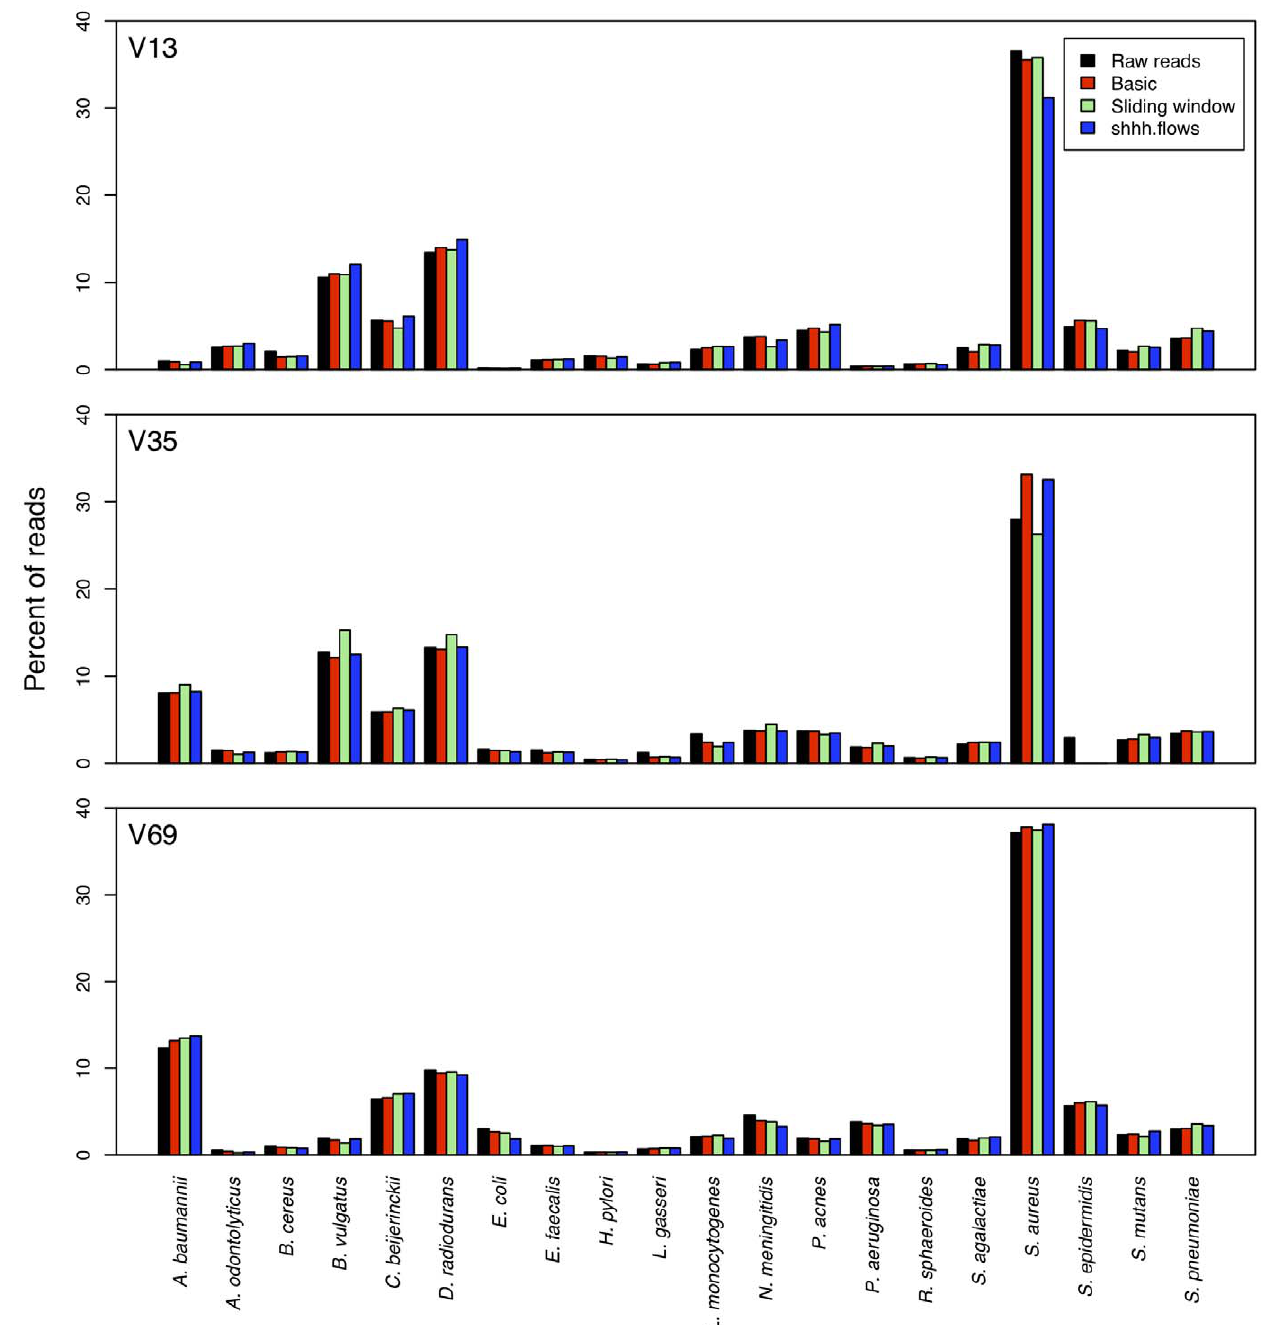
Figure 4. Differences in relative abundance of each sequence type in the raw unprocessed reads, following the Basic sequence curation steps, and at the end of the two pipelines. Each bar represents the average relative abundance for 30 sequencing collections.